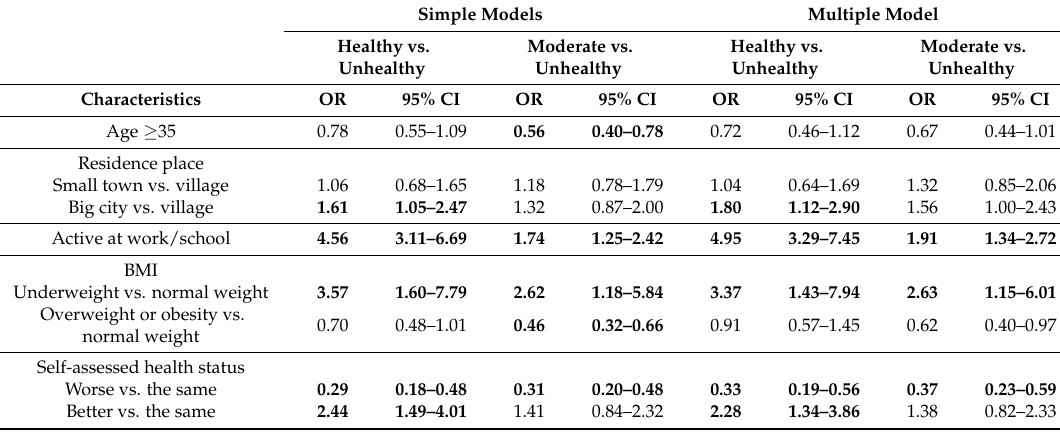
Table 2. Chance of a healthy and moderate lifestyle category against different factors. Simple Models